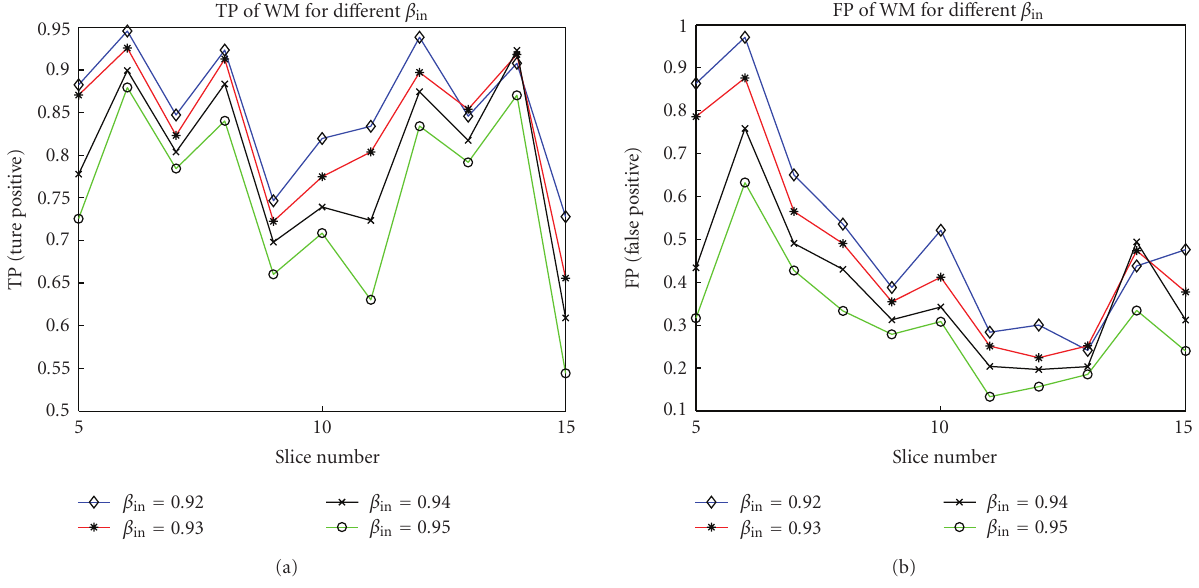
Figure 13: (a) TP (True Positive) and (b) FP (False Positive) of WM segmentation for di ff erent weights β in